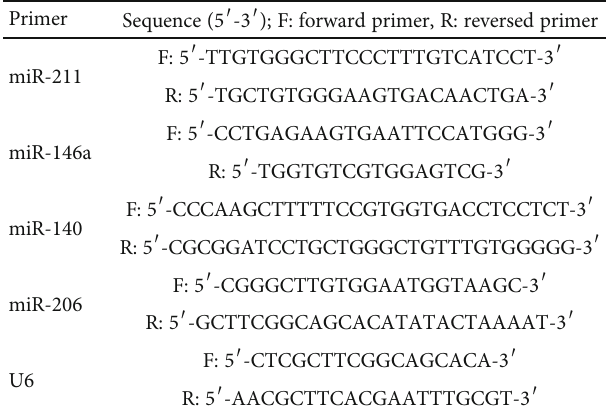
Table 1: qPCR primer